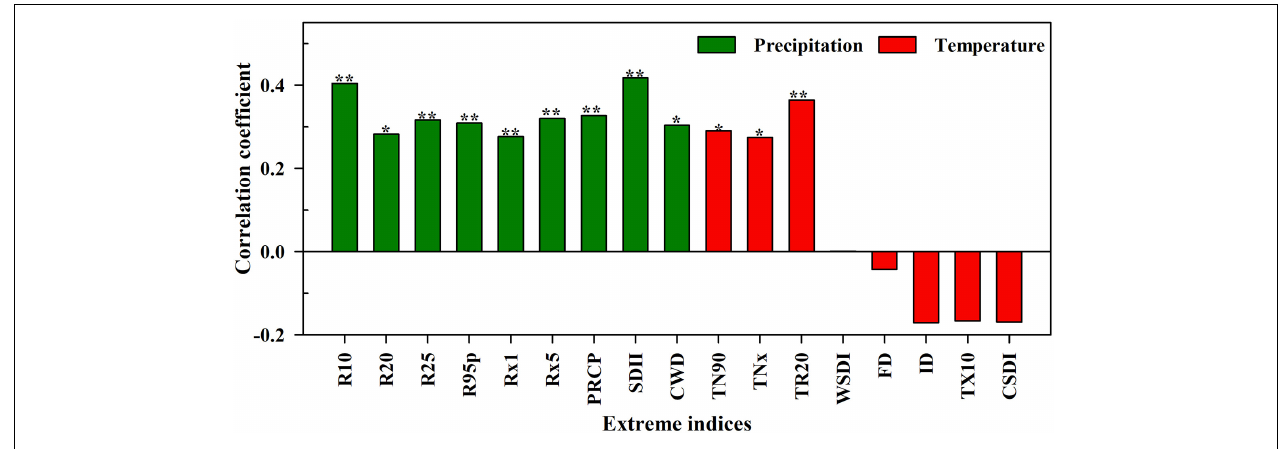
FIGURE 6 | Correlations between extreme climate indices and tree-ring chronology index of Malus sieversii in the non-degraded area (* p < 0.05, ** p <